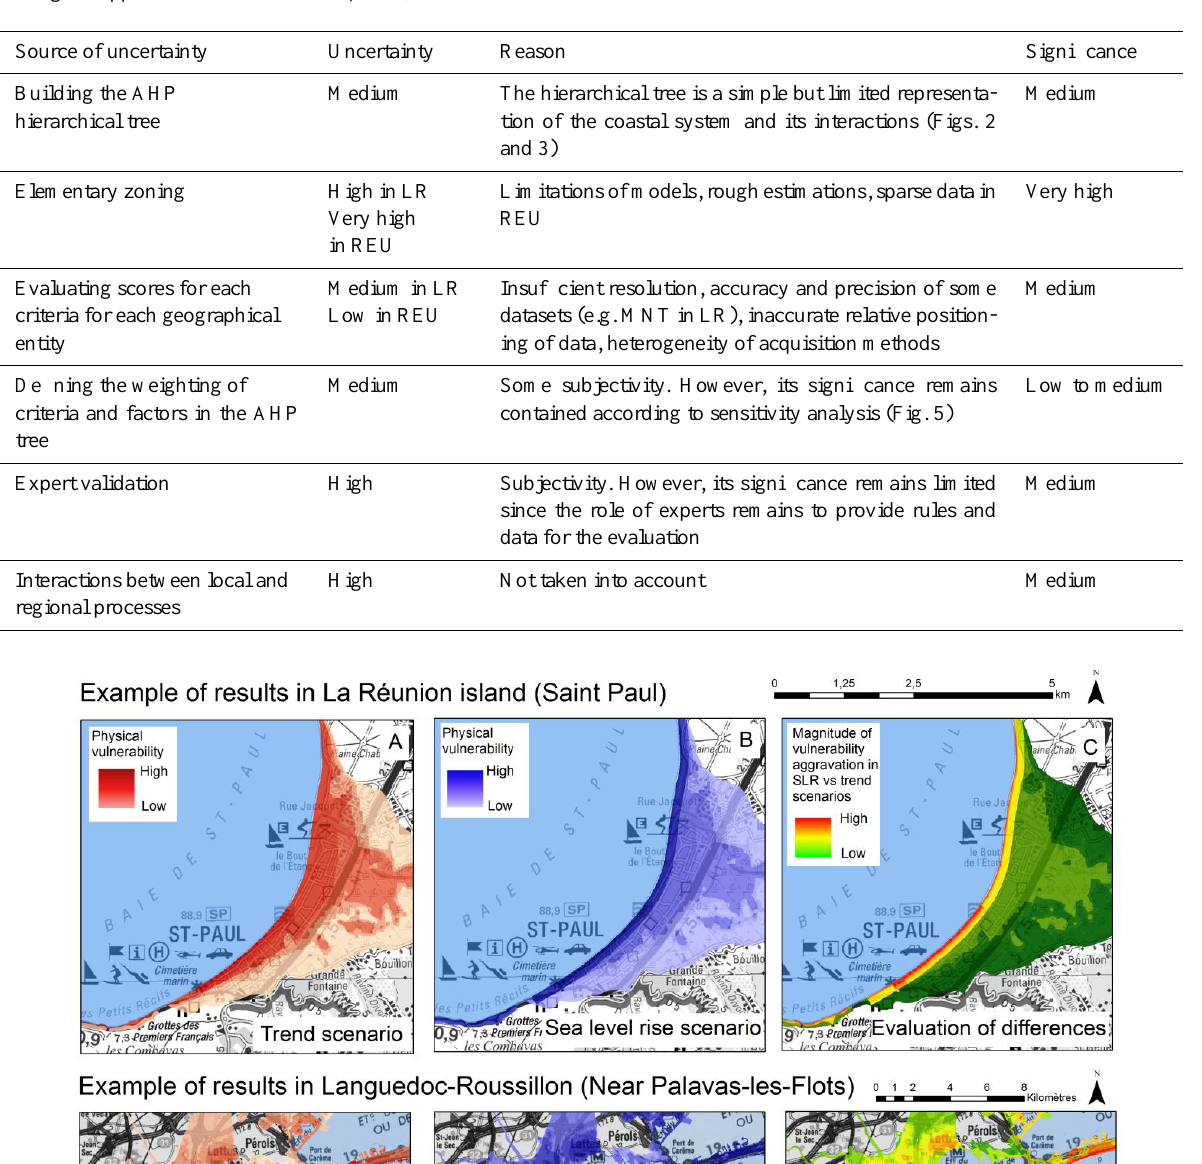
Table 6. Qualitative assessment of uncertainties for physical vulnerability assessment in Languedoc-Roussillon (LR) and La R´eunion (REU) (following the approach of Bell and Glade, 2004).